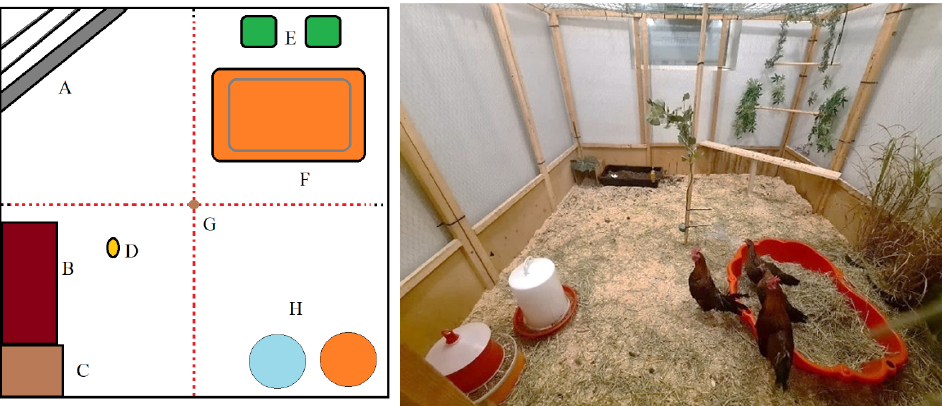
Figure 1. Experimental setup of the enriched observation enclosures. (A) Perches, (B) Dust bath, (C) Nest box, (D) Corncob, (E) Plants, giant Miscanthus, (F) Pool with hay and worms, (G) Pole with seashell supply, (H) Food and water. The dotted line shows the borders between four equally sized virtual zones, not visible to the chickens. The picture to the right shows the view of the pen from the perspective of the observer .